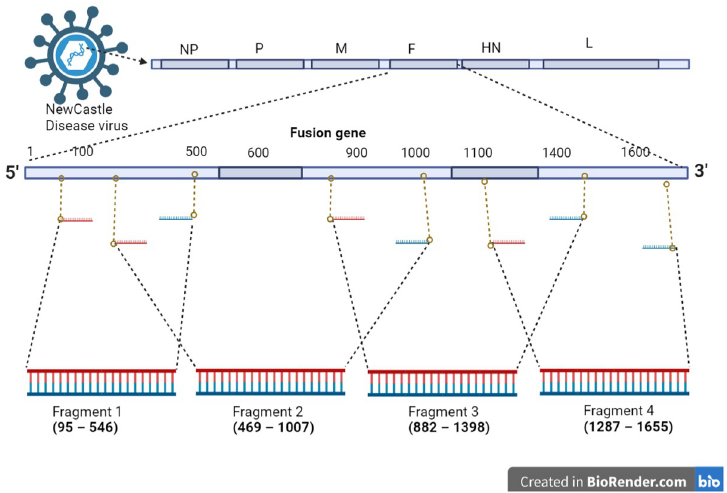
Fig 2. Targeted Fusion gene tiled PCR amplification on NDV genome using designed primers. The image was created using Biorender web app [32].